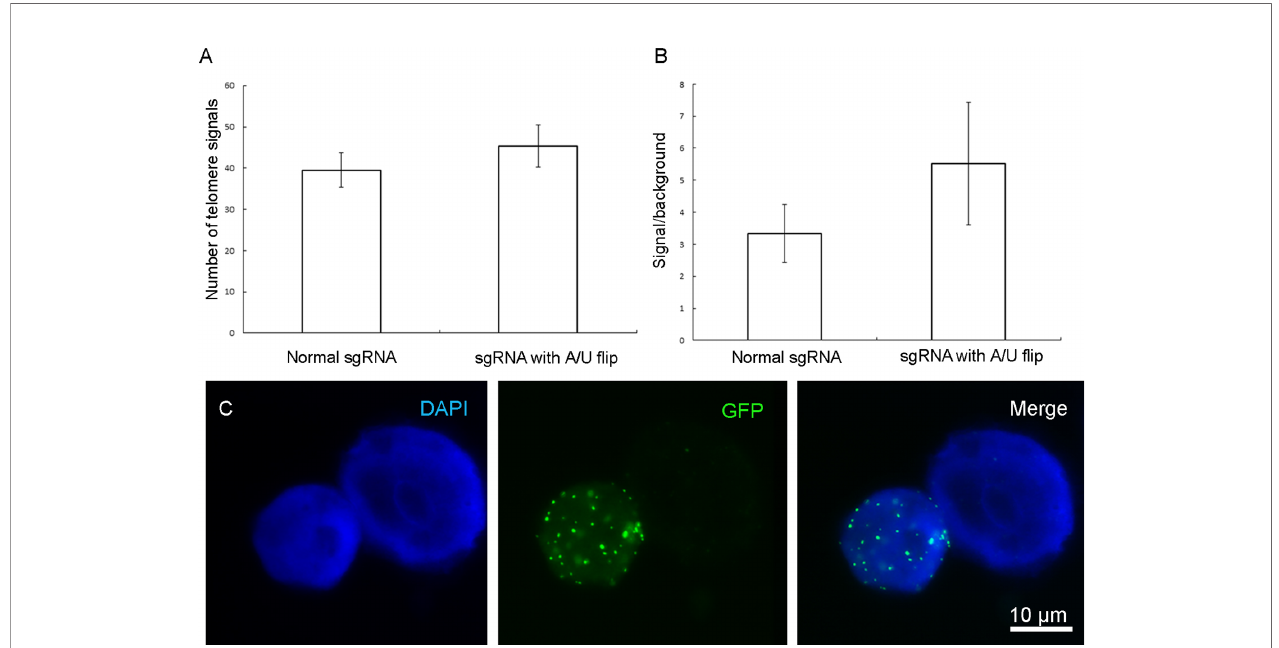
FIGURE 6 | Effect of changing the sgRNA scaffold with a U/A fl ip and extension on quantity and quality of observed telomere signals. No signi fi cant change was observed in the terms of (A) telomere number or (B) signal/background noise ratio (p < 0.05). (C) Labeled telomeres by the vector which has the change in sgRNA scaffold. Measurements were performed based on data from 10 isolated